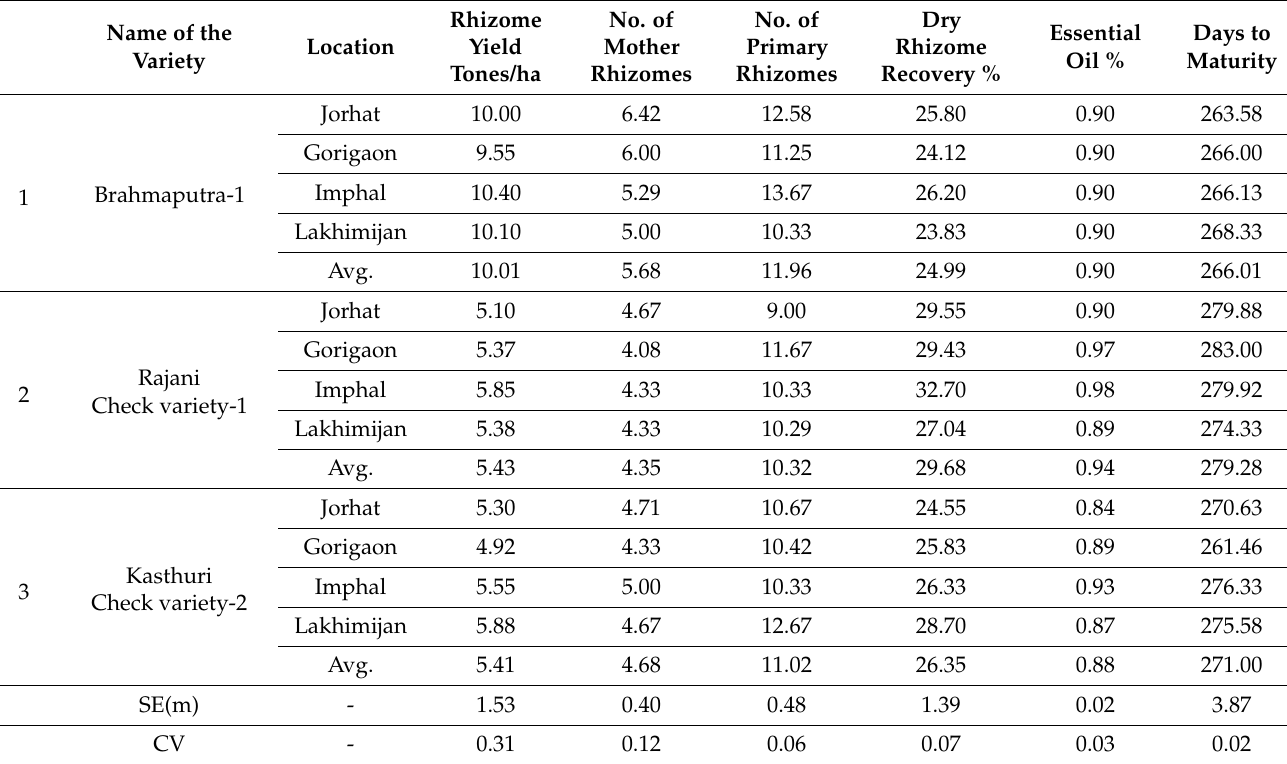
Table 3. Average morpho-chemical data of the three-year (2015, 2016 and 2017) multi-locations trial of the K. galanga variety “Bharamputra-1” and the